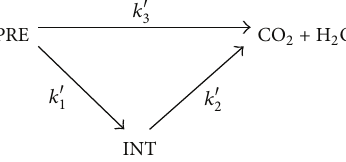
Figure2:SchematicrepresentationofPREmineralization,interme- diates, and final